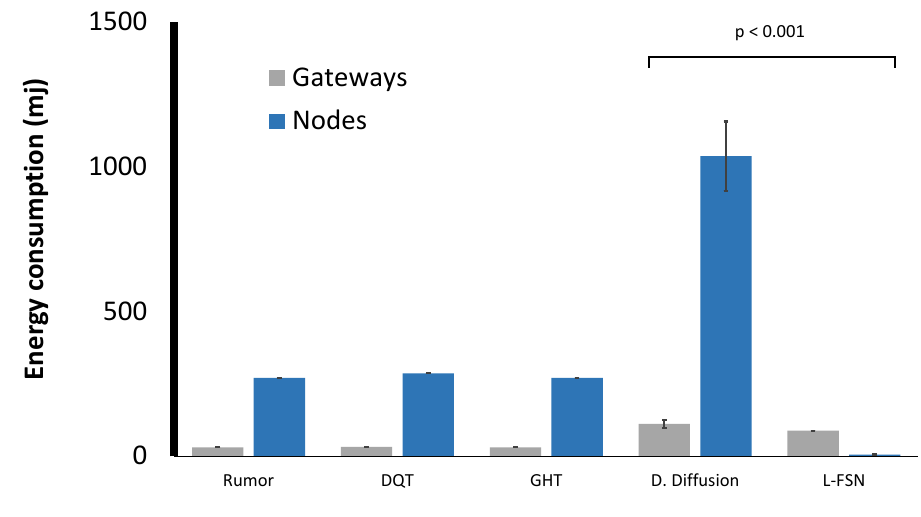
Figure 5. Energy consumption on